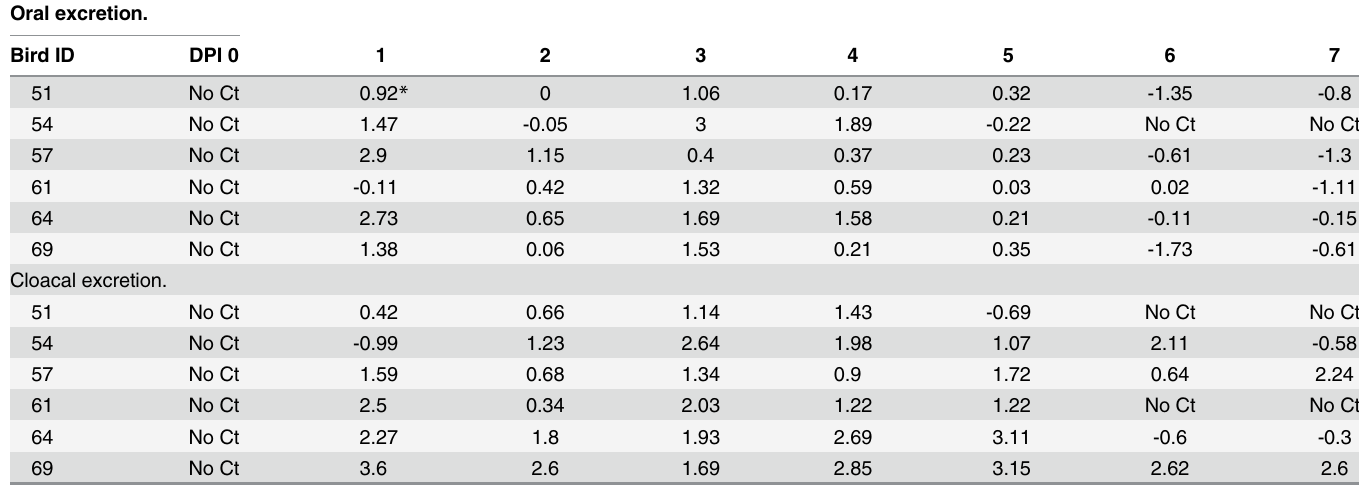
Table 7. Excretion of virus from common eiders experimentally inoculated with 10 6.6 EID 50 of Influenza A/long-tailed duck/Maine/295/2011 (H3N8). Oral excretion. Bird